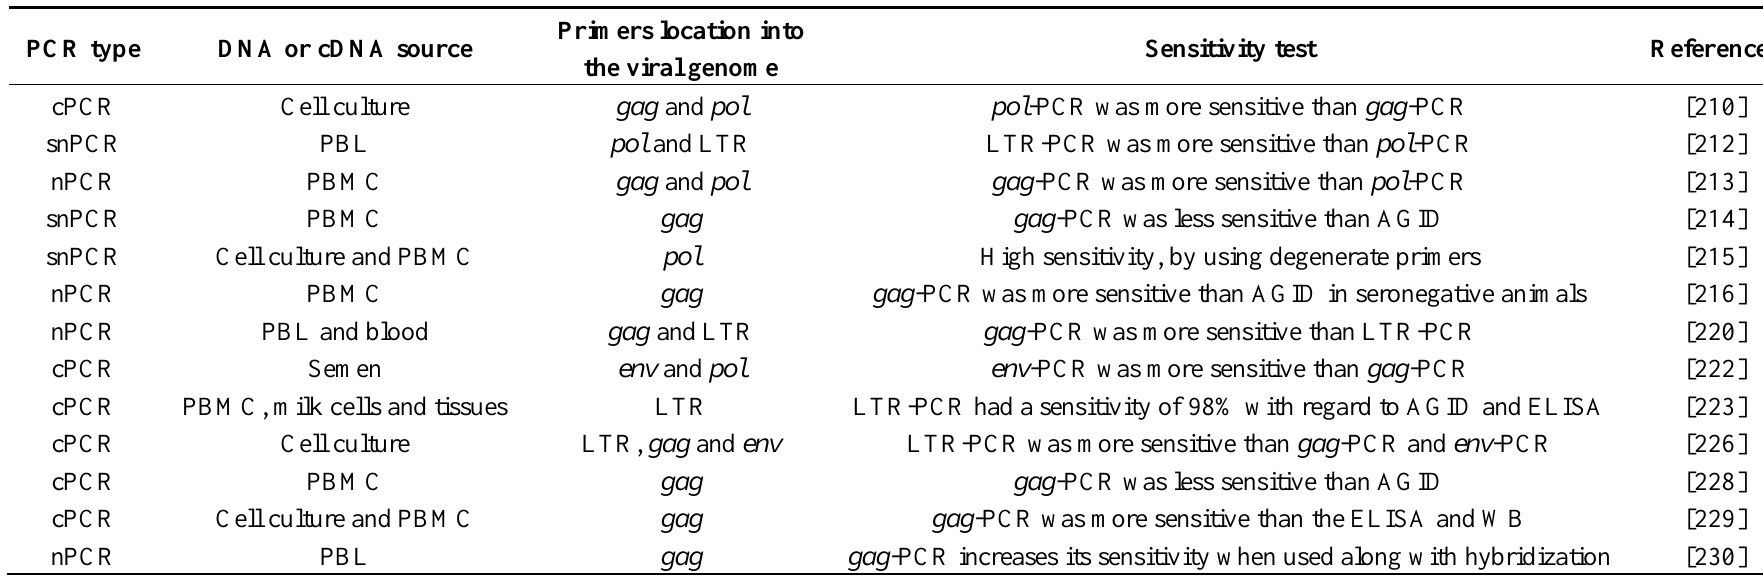
Table 2. Different PCRs techniques, target DNA samples, regions of the viral genome used for PCR design and sensitivity of the PCR method for detection of infection by